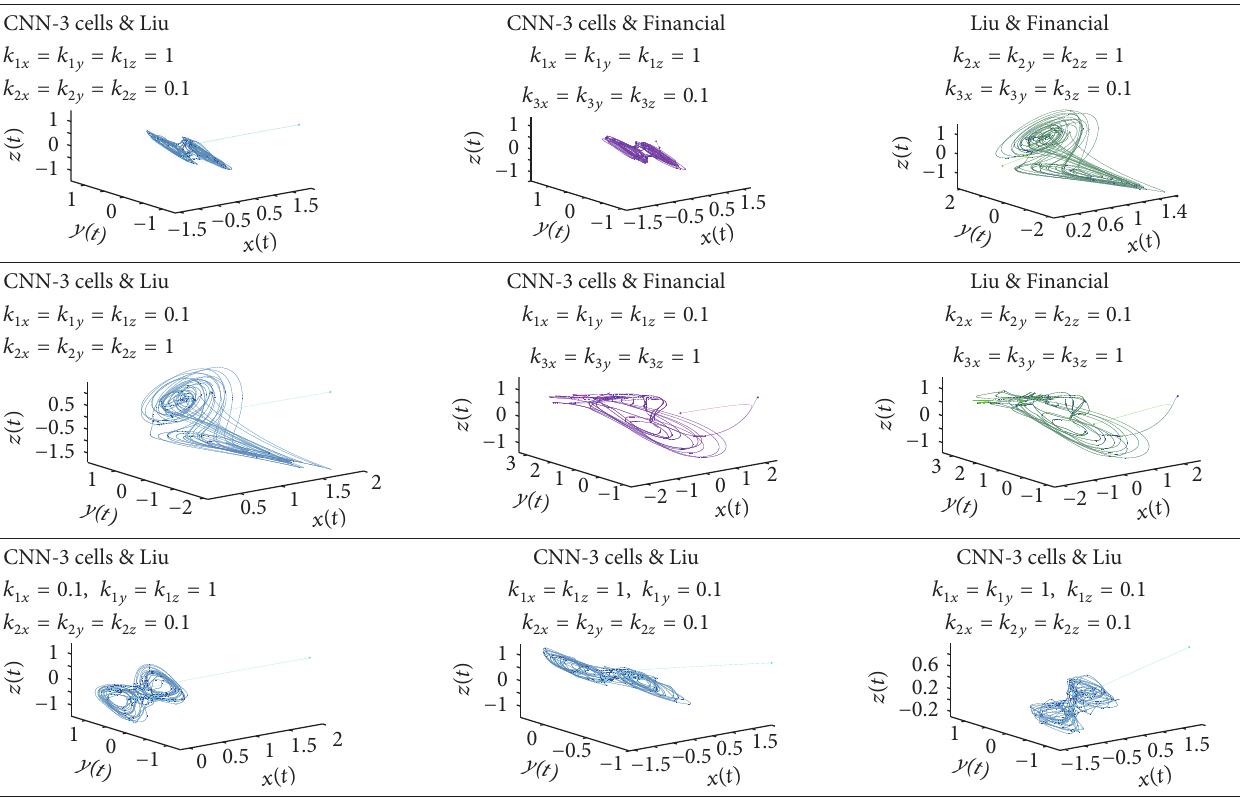
Table 3: Different successfully synchronized linear combinations of the selected